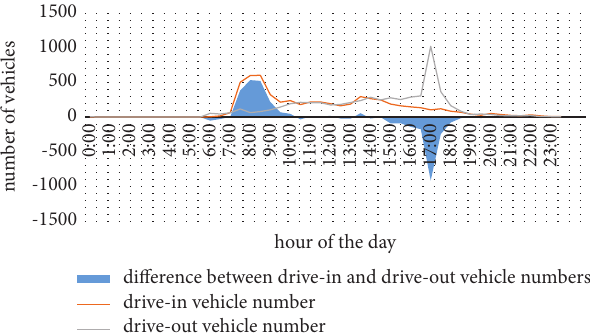
Figure 3: Time distribution of borrowers’ in and out